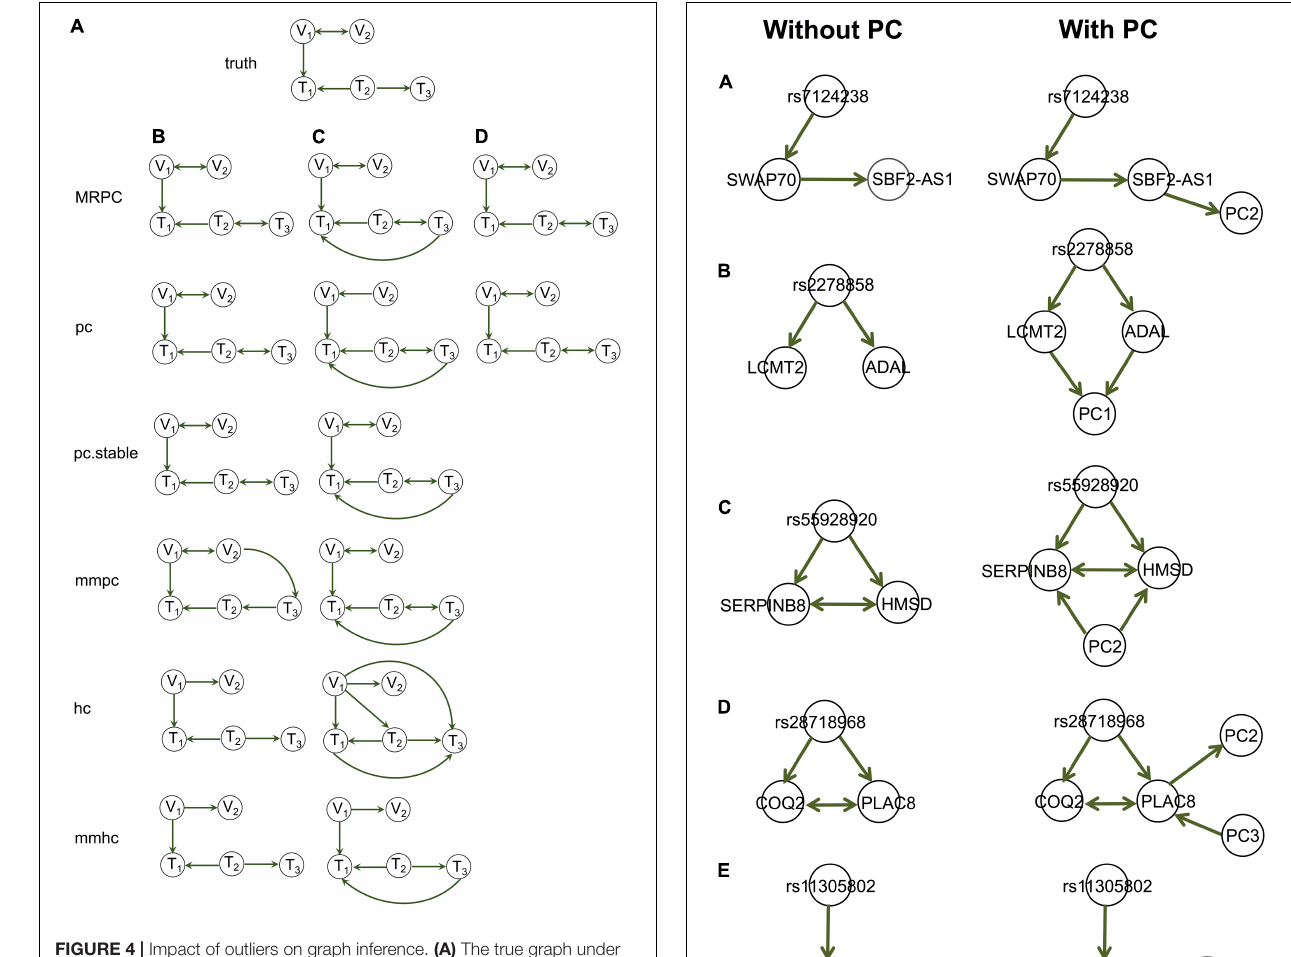
FIGURE 4 | Impact of outliers on graph inference. (A) The true graph under which data of sample size 1,000 with and without outliers were simulated. (B) Inference by MRPC, pc, pc.stable, mmpc, hc, and mmhc on the simulated data that do not contain outliers, using Pearson correlation as input. (C) Inference by the five functions on the simulated data that contain 10 outliers, using Pearson correlation as input. In (B) and (C) the blacklist argument in pc.stable, mmpc, hc, and mmhc was used to disallow edges pointing to a genetic variant. (D) Inference by MRPC and pc on the simulated data with 10 outliers using robust correlation as input.